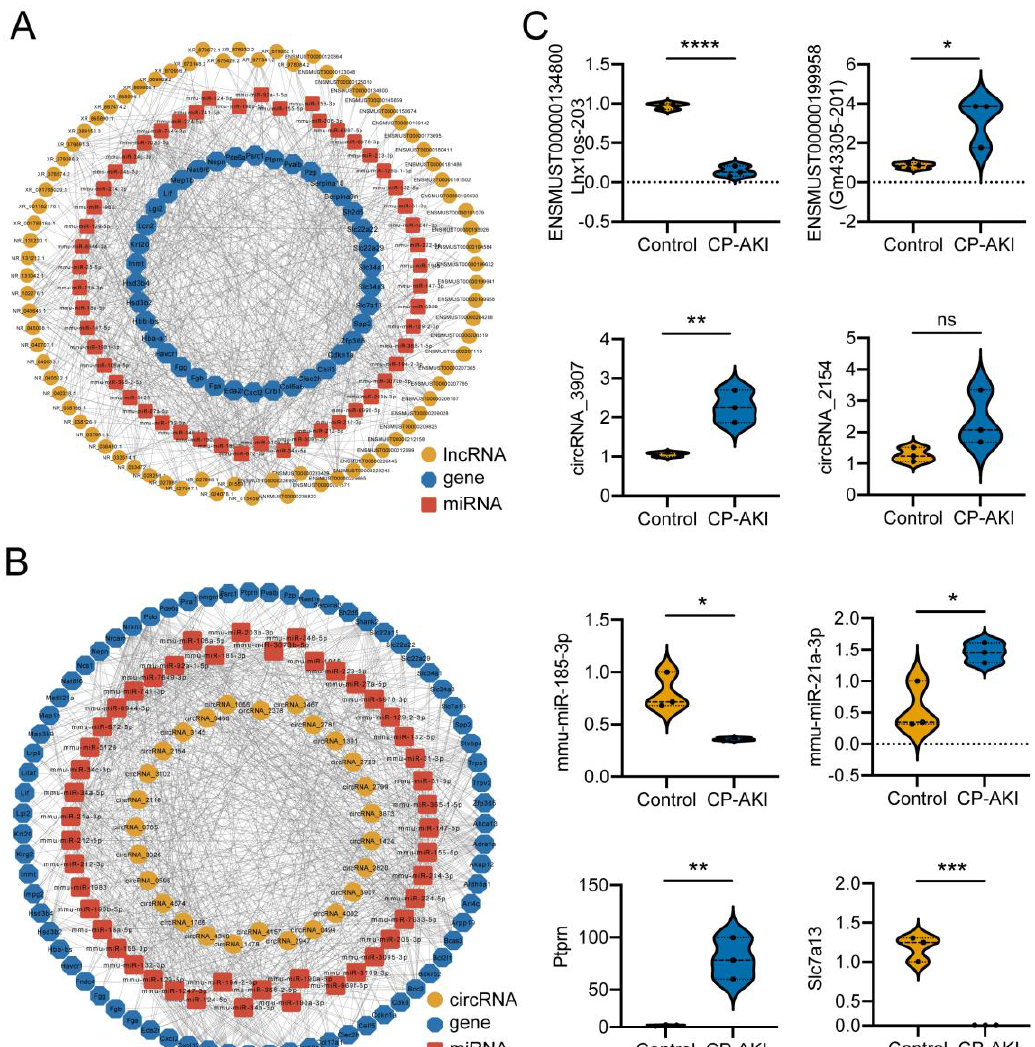
Figure 4. Construction of lncRNA- or circRNA-associated competing endogenous RNA (ceRNA) network. ( A ) LncRNA-associated ceRNA networks in CP-AKI mice. ( B ) CircRNA-associated ceRNA networks in CP-AKI mice. The circular frames denote lncRNAs or circRNAs, octagonal nodes represent mRNAs, and square nodes indicate miRNAs. ( C ) Validation of transcript expression by quantitative real-time PCR (RT-qPCR) between CP-AKI and control mice ( n = 3, respectively). * p < 0.05, ** p < 0.01, *** p < 0.001, **** p < 0.0001; ns, not significant.